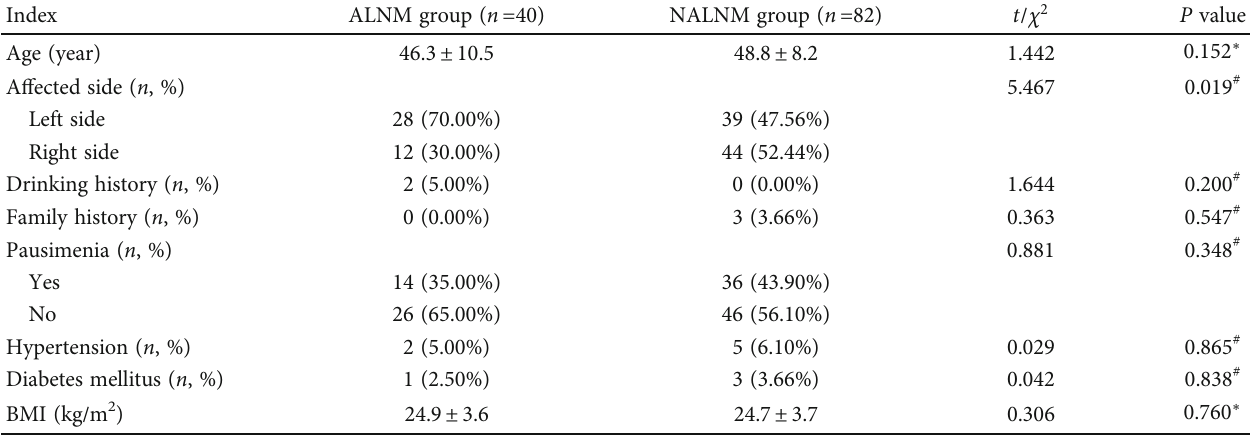
Table 1: Comparison of general data between the two groups.